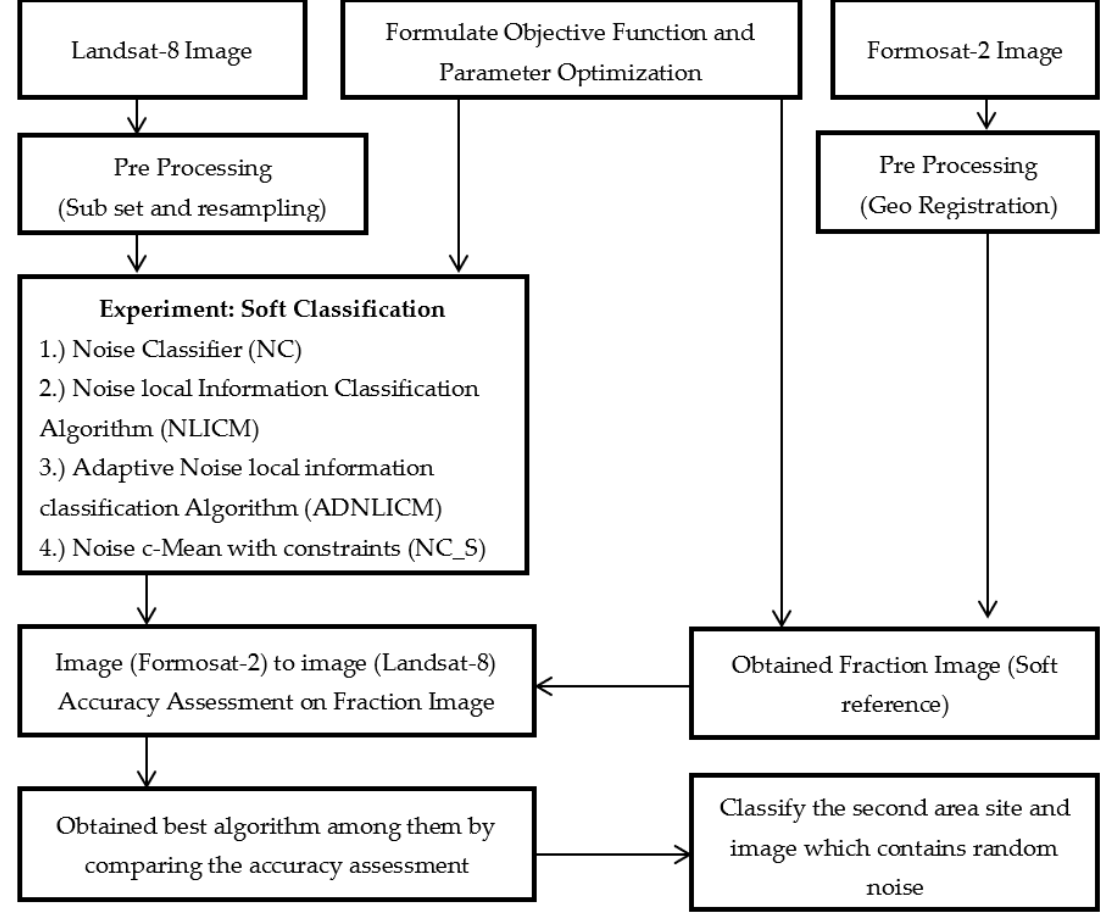
Figure 9. Flow diagram of Adopted